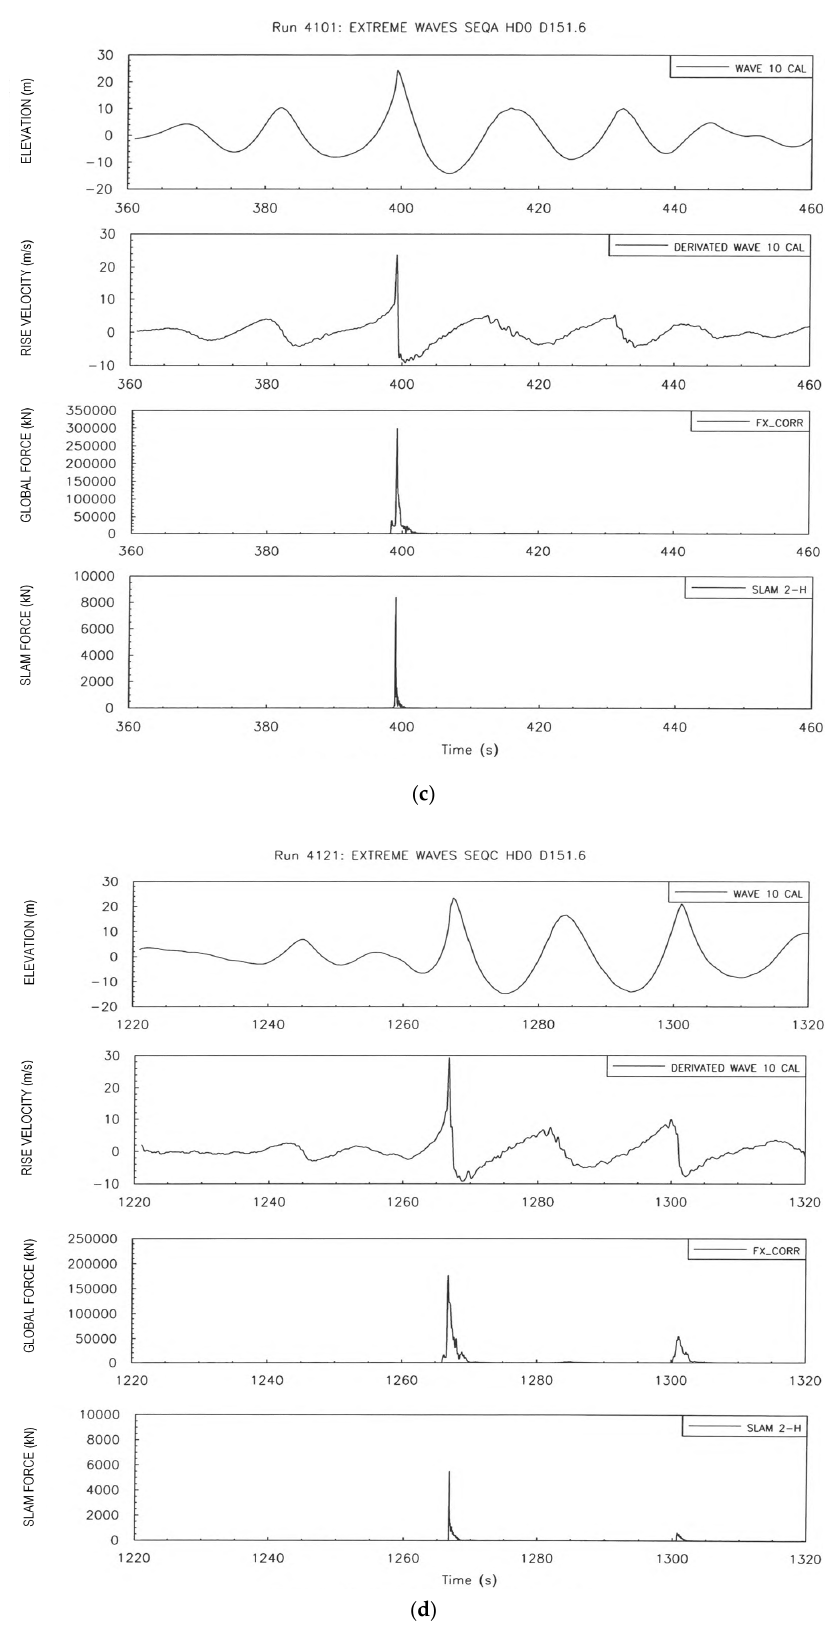
Figure 12. The same as Figure 10, but for two irregular wave events ( c , d ).